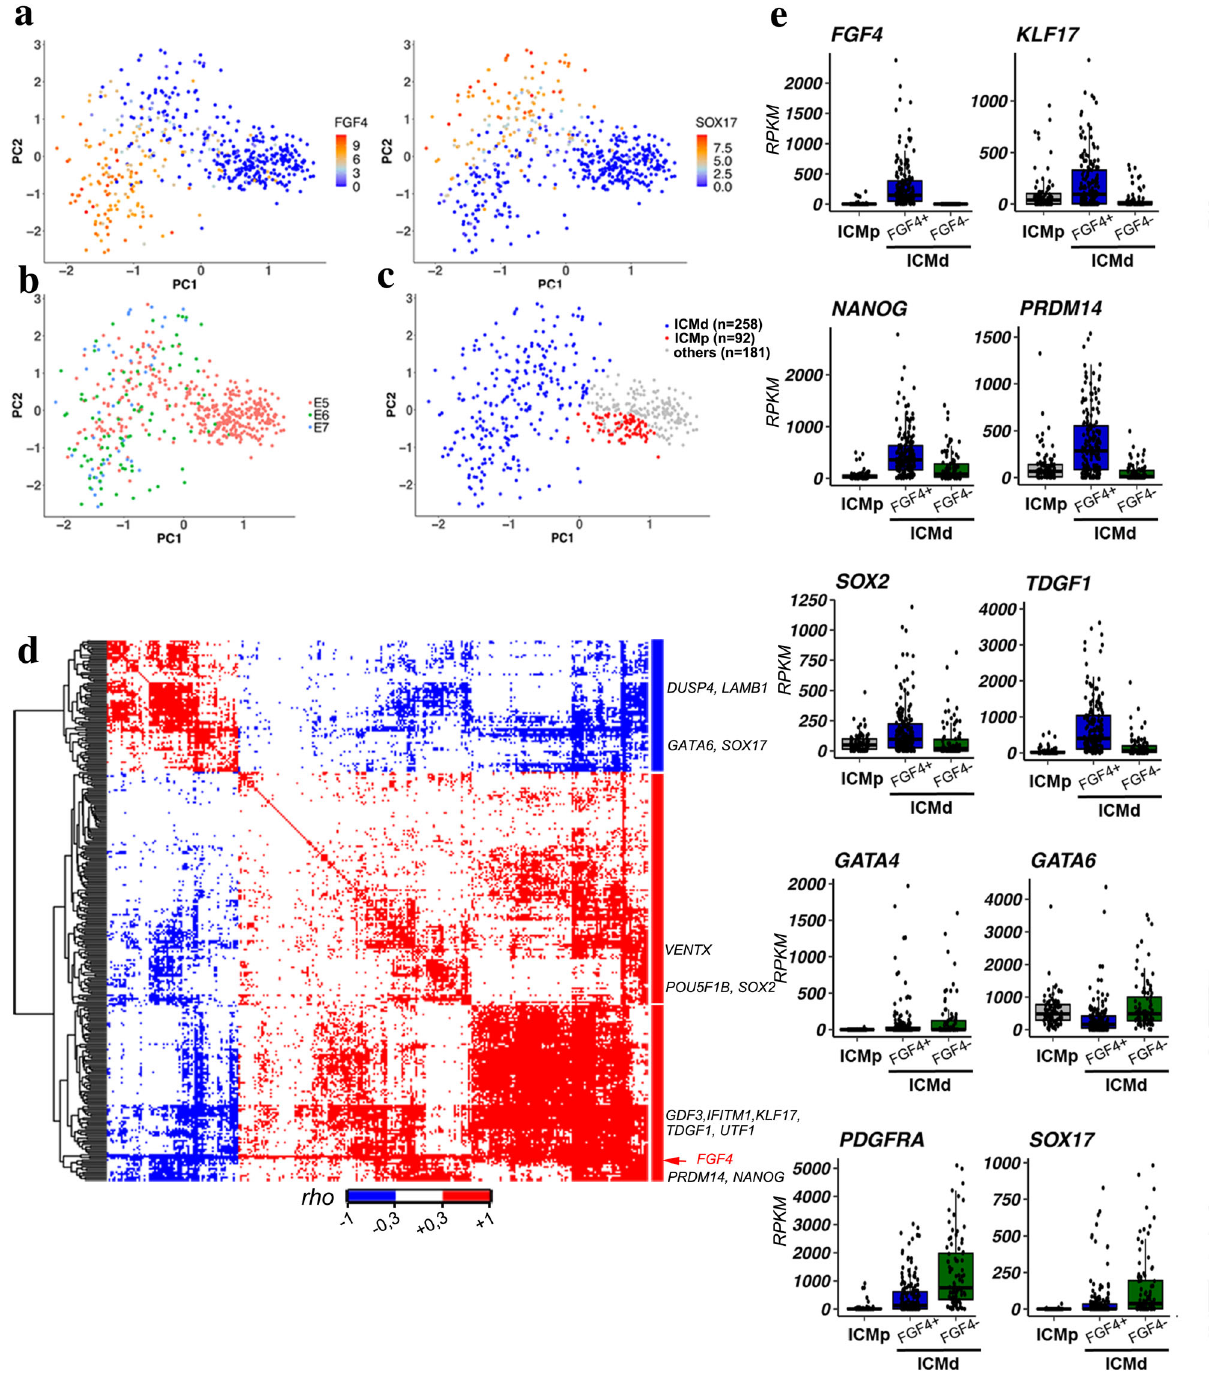
Fig. 4 Single-cell RNA sequencing data analysis in human ICMs. a PCA map of human cells from 52 embryos with graded colours indicating FGF4 and SOX17 expression levels in E5 cells and E6-E7 ICM cells (PC1 Score = 28.09%, PC2 score = 11.34%, PC3 score = 6%). b Same PCA plot as in ( a ) where developmental stages are represented by the indicated colours. c Same PCA plot showing ICMd and ICMp cells (see Supplementary data 8 for the list of cells and their allocation). d Spearman correlation matrix for paired expression of the 308 FGF4 -correlated genes in the 258 human ICMd cells. Genes are ordered in a hierarchical tree for similarity (see Supplementary data 9 for detailed map in the vector-based PDF fi le). e Single cell normalized expression levels of Epi and PrE markers in ICMp ( n = 88) and ICMd ( FGF4 + ( n = 172) and FGF4 - ( n = 86)) cells (Supplementary data 8); Two-sided Wilcoxon test between FGF4 + and FGF4- ICMd cells ( p -values: FGF4 p < 2.00 e − 16 ; KLF17 p = 5.80 e − 11 ; NANOG p = 5.40 e − 09 ; PRDM14 p < 2.00e − 16 ; SOX2 p = 6.10 e-08 ; TDGF1 p = 2.40 e − 13 ; GATA4 p = 0.38; GATA6 p = 3.10 e − 12 ; PDGFRA p = 1.40 e − 11 ; SOX17 p = 8.00 e − 08 ). For boxplots: The edges of the box represent the 25th and 75th quartiles. The median is represented by the central line. The whiskers extend to 1.5 times the interquartile range (25th to 75th percentile). Cells are plotted individually.